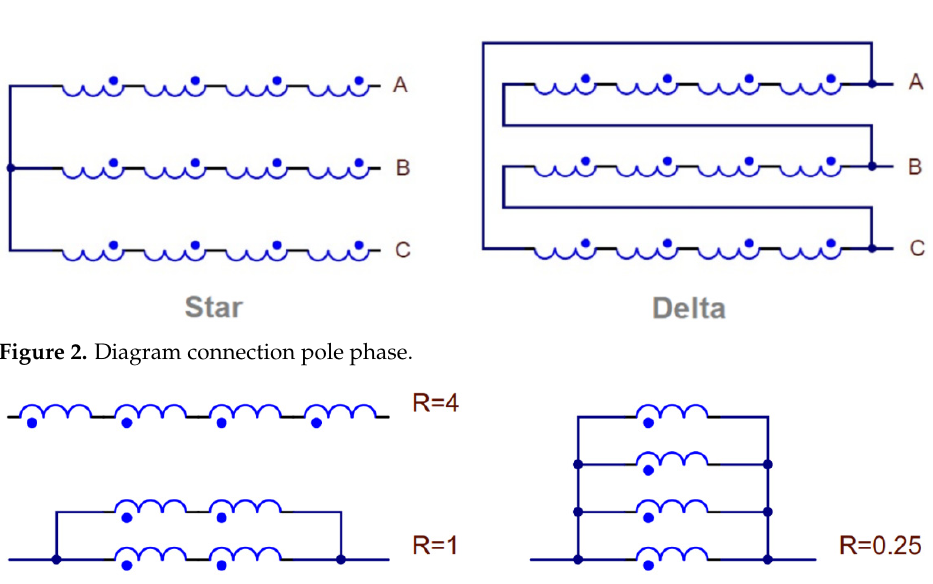
Figure 3. Possible connection schemes for four poles.